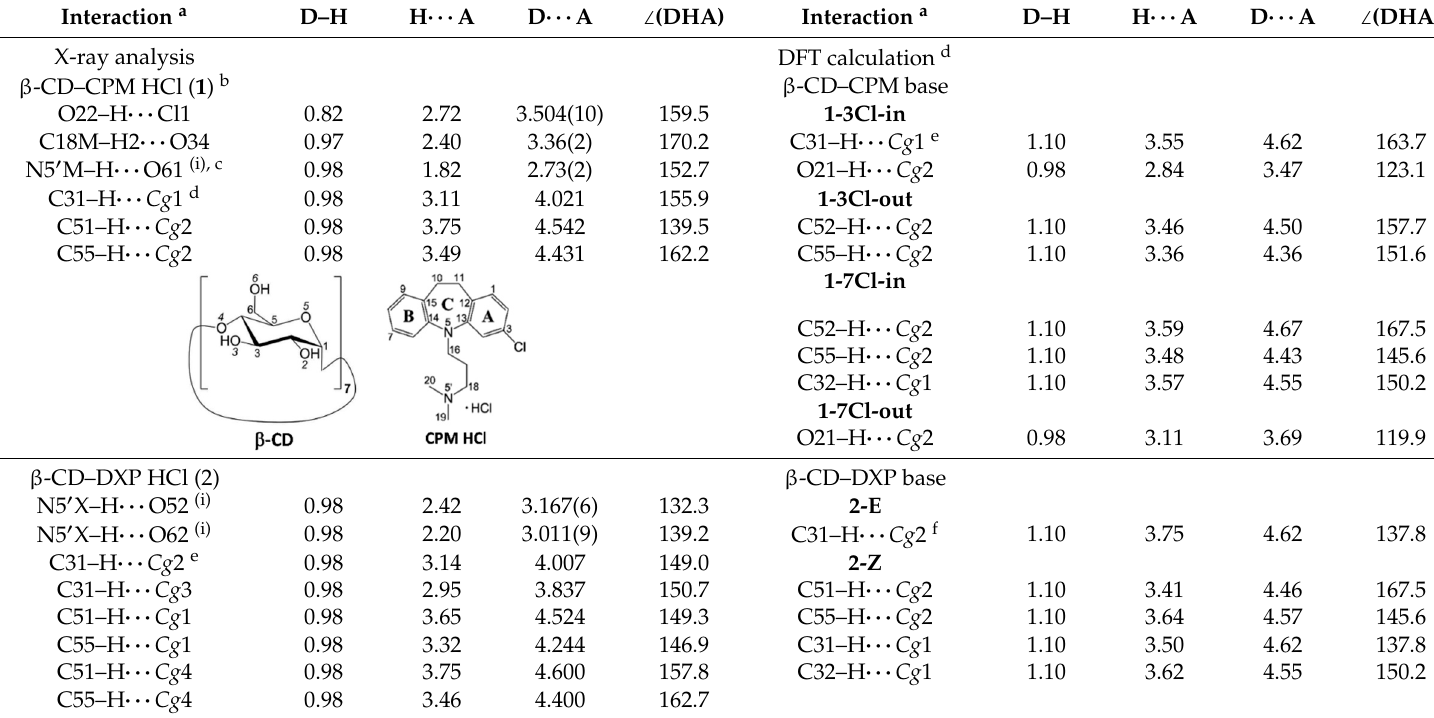
Table 2. Selected host–guest interactions in the β -CD–CPM and the β -CD–DXP inclusion complexes deduced from X-ray analysis and DFT full-geometry optimization [Å, o ].